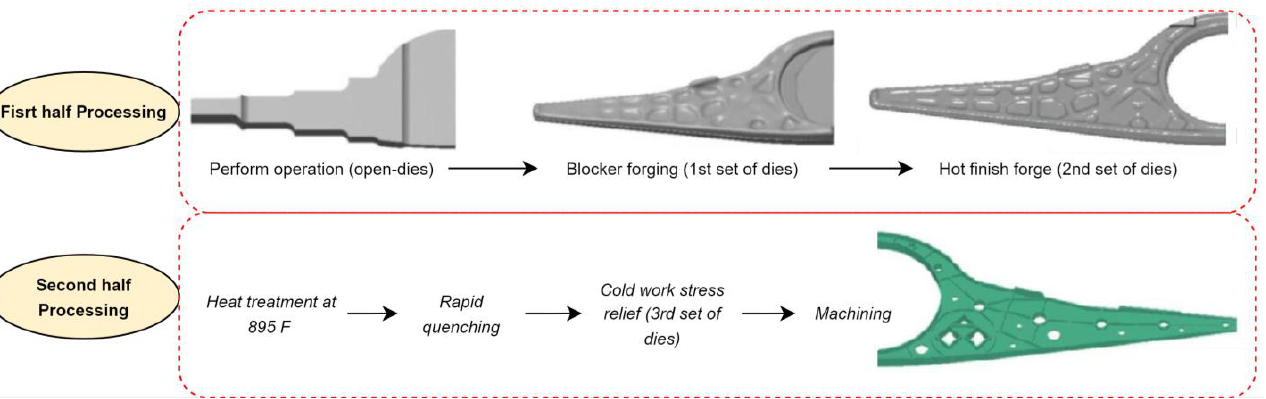
Figure 23. Schematic illustration of MA956 stiffener rings on P92 steel pressure vessel for creep resistance enhancement (reprinted from conference presentation [127] permission not required).